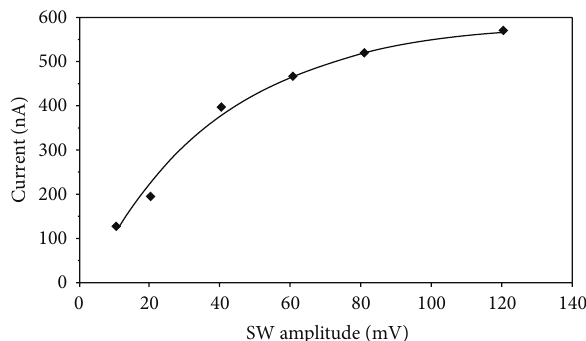
Figure 5: The effect of SW amplitude on the current of the square- wave stripping peak for 1.7 × 10 −7 molL −1 Ni(II)-salen complex. Other conditions as in Figure 4.